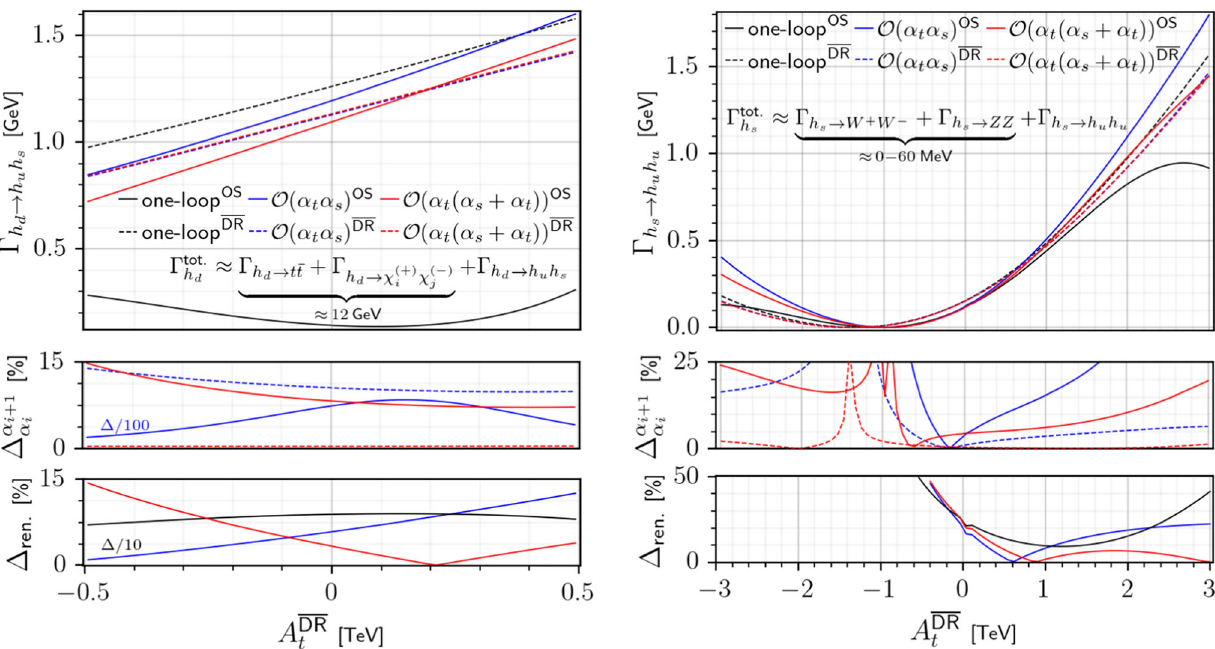
Fig. 4 Upper: Partial decay width of h d → h u h s for P2OS (left) and relative correction defined analogously to Eq. (39), but for the partial of h s → h u h u for BP10 (right) at one-loop order (black), two-loop decay width. Lower: The relative renormalisation scheme dependence α ) (blue) and two-loop O (α (α + α )) (red) in the OS (full) O (α defined analogously to Eq. (40), but for the partial decay width, for all t s t s t three loop orders and DR scheme (dashed) as a function of A DR t . In the right plot the dashed blue and red lines nearly lie on top of each other. Middle: The